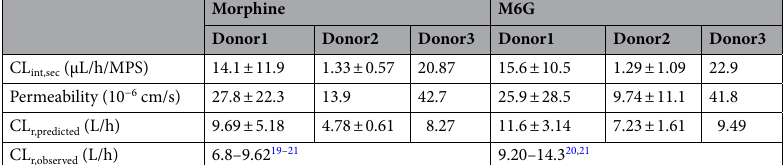
The morphine (Fig. 4 panel a and b) and M6G (Fig. 4 panel c and d) drug models were independently verified using observed plasma morphine and M6G concentration–time data in healthy subjects after intrave- nously administering morphine 19,22 or M6G 23 . Then, the morphine-M6G parent-metabolite link was verified using observed plasma M6G concentration–time data after intravenous administration of morphine to healthy subjects 19,22 . The absolute average fold error values for morphine and M6G simulations (Fig. 4) ranged from 1.18